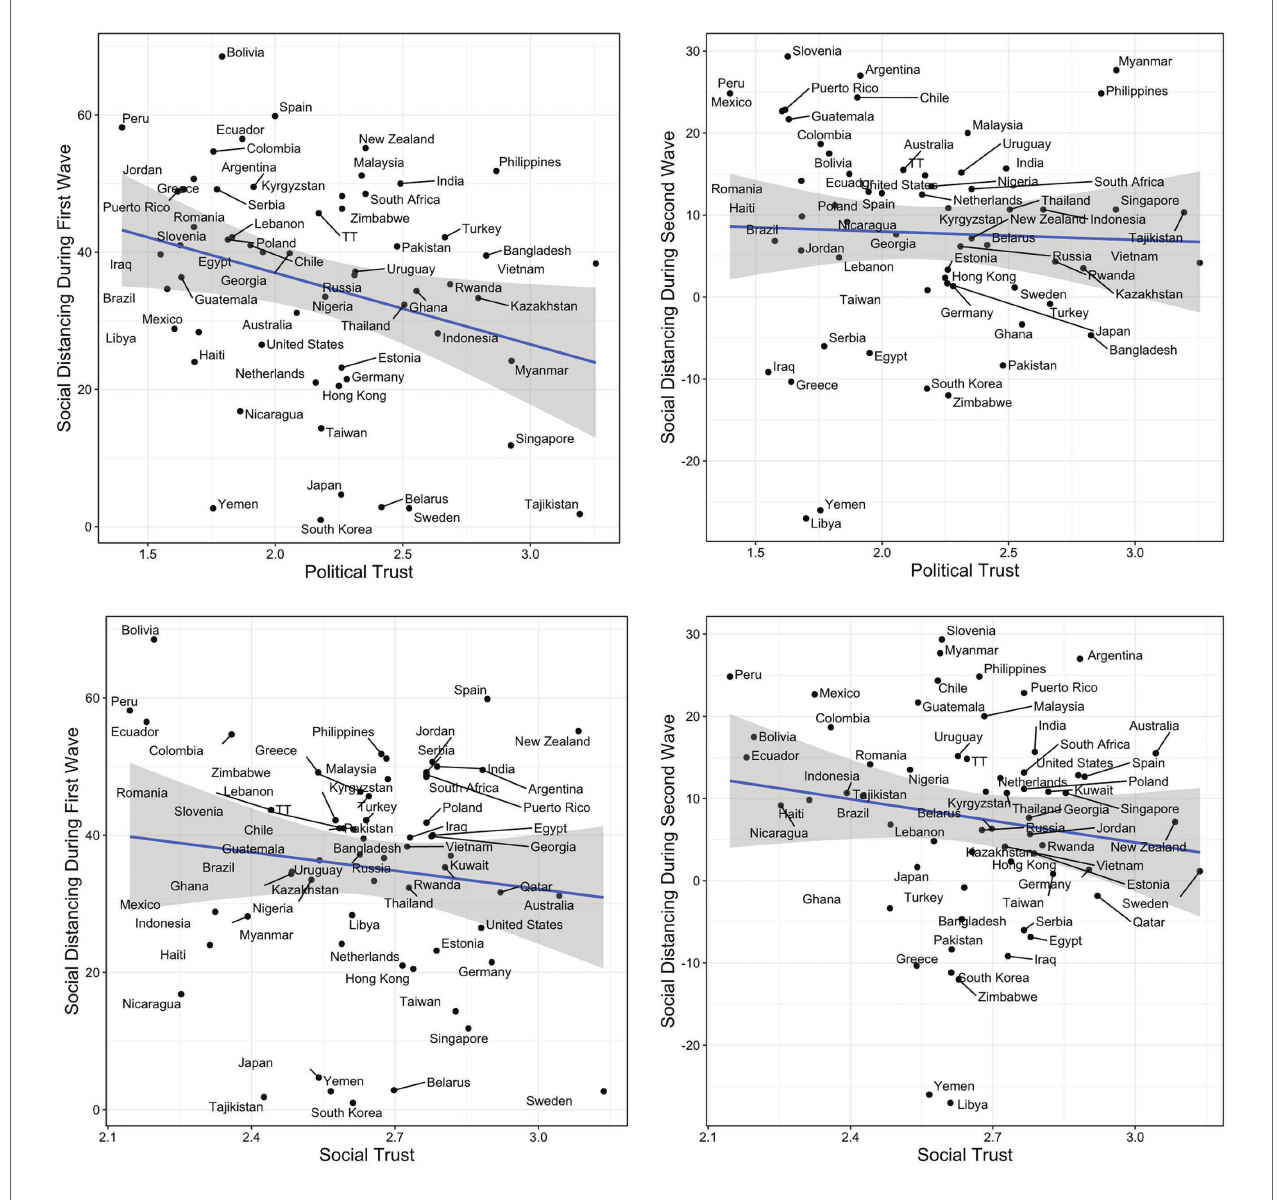
FIGURE 3 | Correlation plots for political and social trust and social distancing during the first and second wave of the pandemic in Study 3. TT, Trinidad and Tobago. Ribbon represents 95% confidence